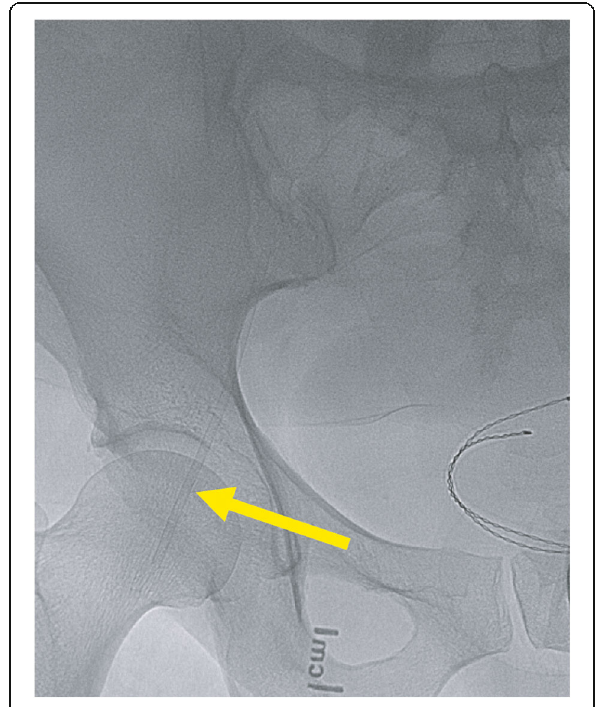
Fig. 3 Initial Gooseneck snaring of the catheter fragment (blue arrow) and retraction of the sheath fragment (yellow arrow)